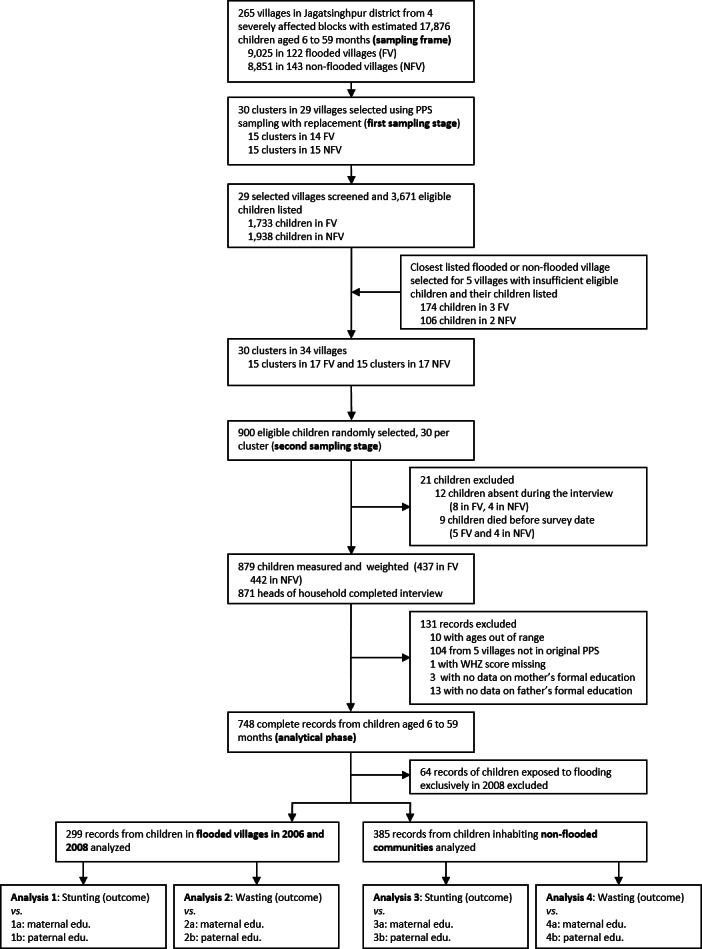
Flow diagram of sampling procedure, sample obtained and analyses undertaken.